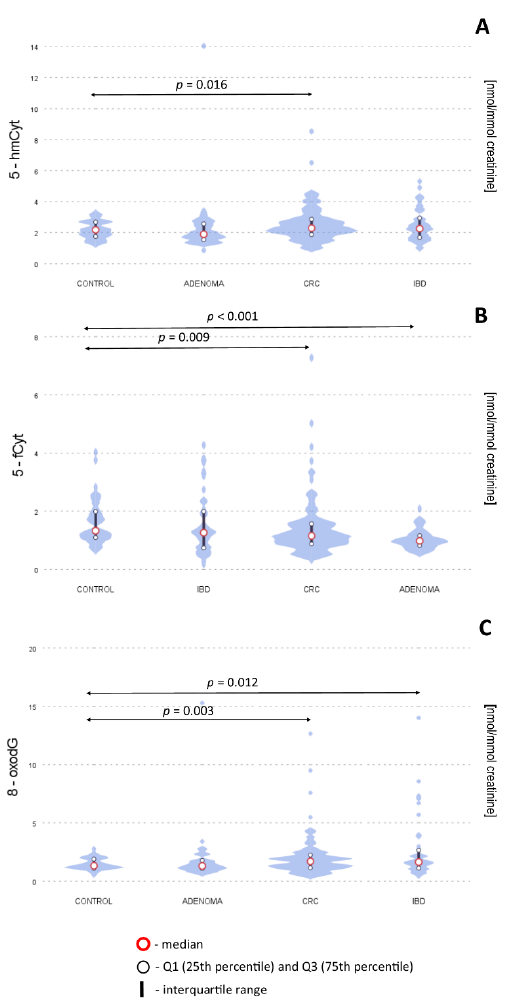
Figure 1. Levels of 5-hmCyt ( A ), 5-fCyt ( B ) and 8-oxodG ( C ) in urine from healthy controls, patients with adenomatous polyps, colorectal cancer (CRC) and inflammatory bowel disease (IDB). The results presented as medians and interquartile ranges. 5-hmCyt: 5-hydroxymethylcytosine; 5-fCyt: 5-formylcytosine; 8-oxodG: 8-oxo-2′-deoxyguanosine.